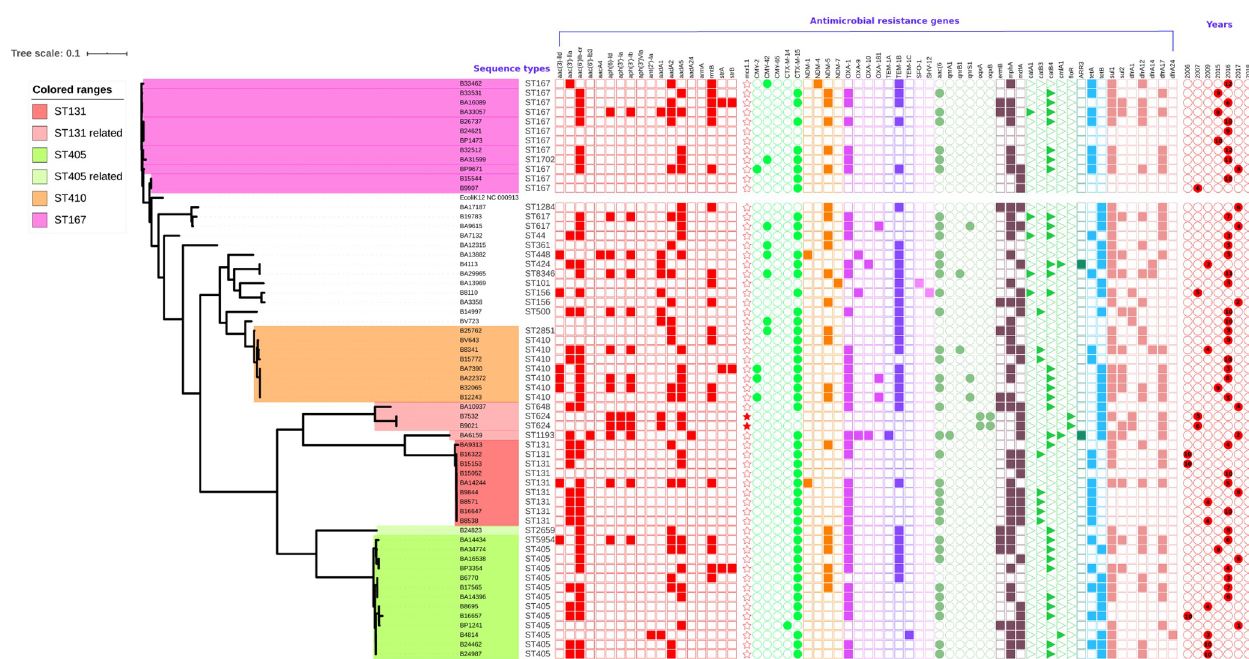
Fig 3. Antimicrobial resistance genes observed in MDR E . coli compared to the SNP based phylogeny. Depicting prevalence of bla NDM-5 among carbapenemases and bla CTX-M-15 among